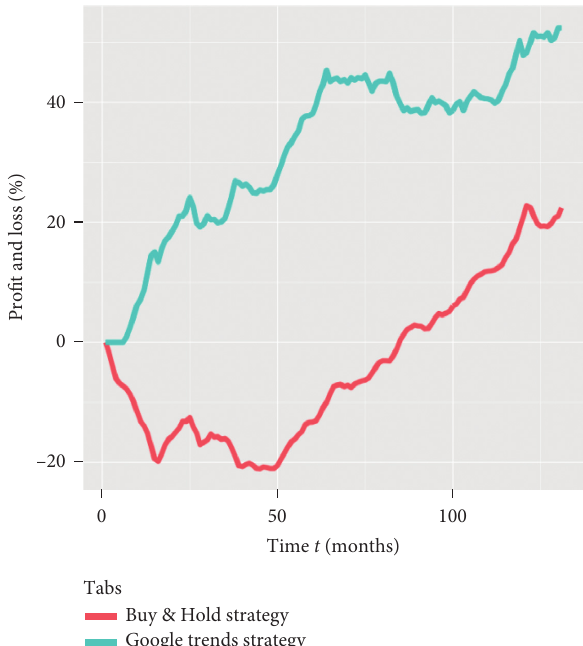
Figure 1: The cumulative profits of a hypothetical investment strategy’s portfolio. The search term “bankruptcy” is taken as an example to show the differences in profits between Google Trends strategy and Buy & Hold strategy. The green line stands for the cumulative profits gained through Google Trends strategy with 131 months plotted as a function of time, while the red line stands for Buy & Hold strategy in a traditional